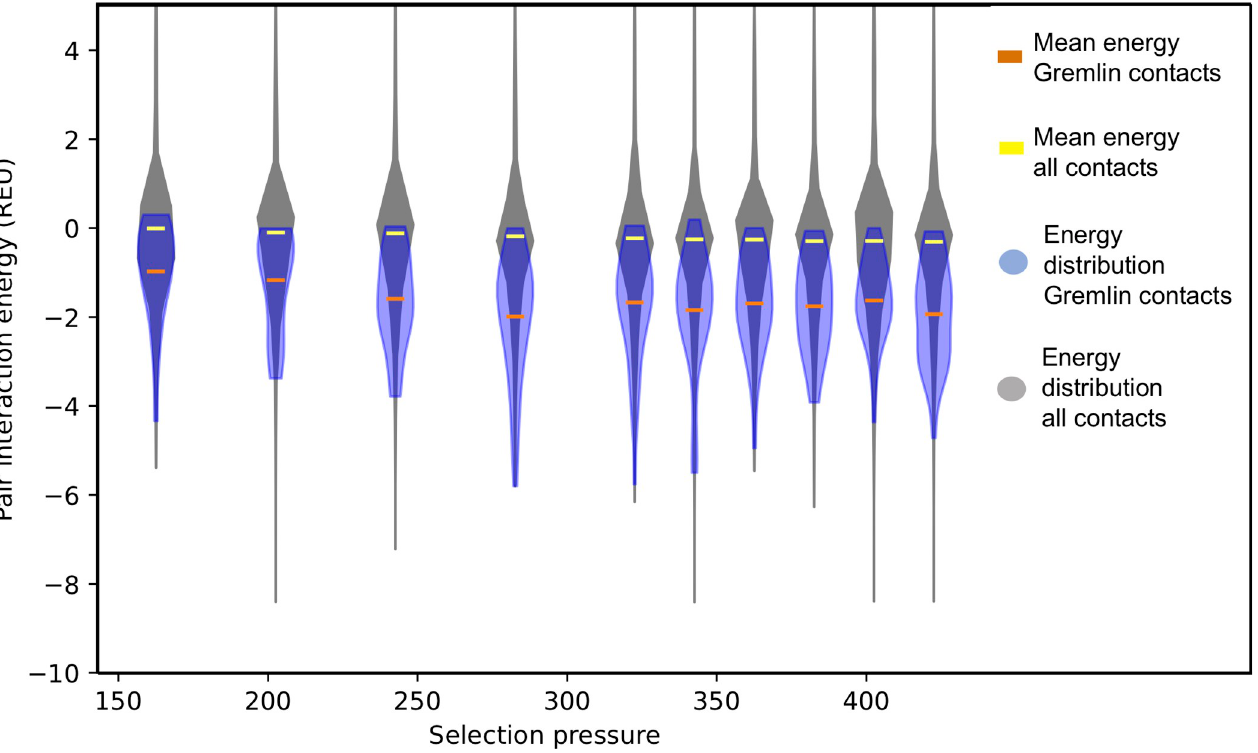
Fig 6. Pair interaction energy for contacts predicted from alignments. Distribution of pair interaction energies for contacts predicted by Gremlin (blue, mean represented by the orange line) and all contacts within the structure (gray, mean represented by the yellow line) as a function of selection pressure. The width of the violin is related to the frequency of a given pair interaction value. Energies in Rosetta Energy Units (REU).